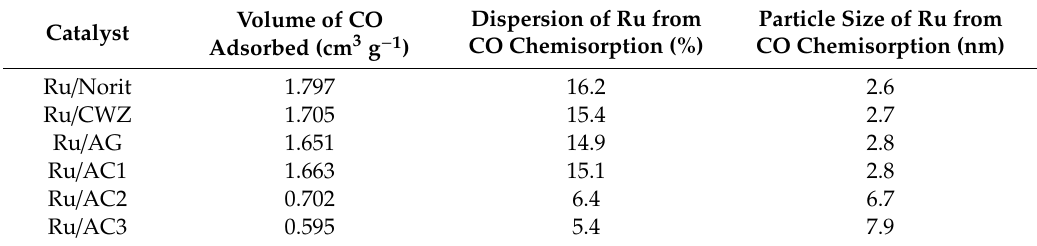
Table 3. Carbon monoxide chemisorption data, dispersion, and particle size of